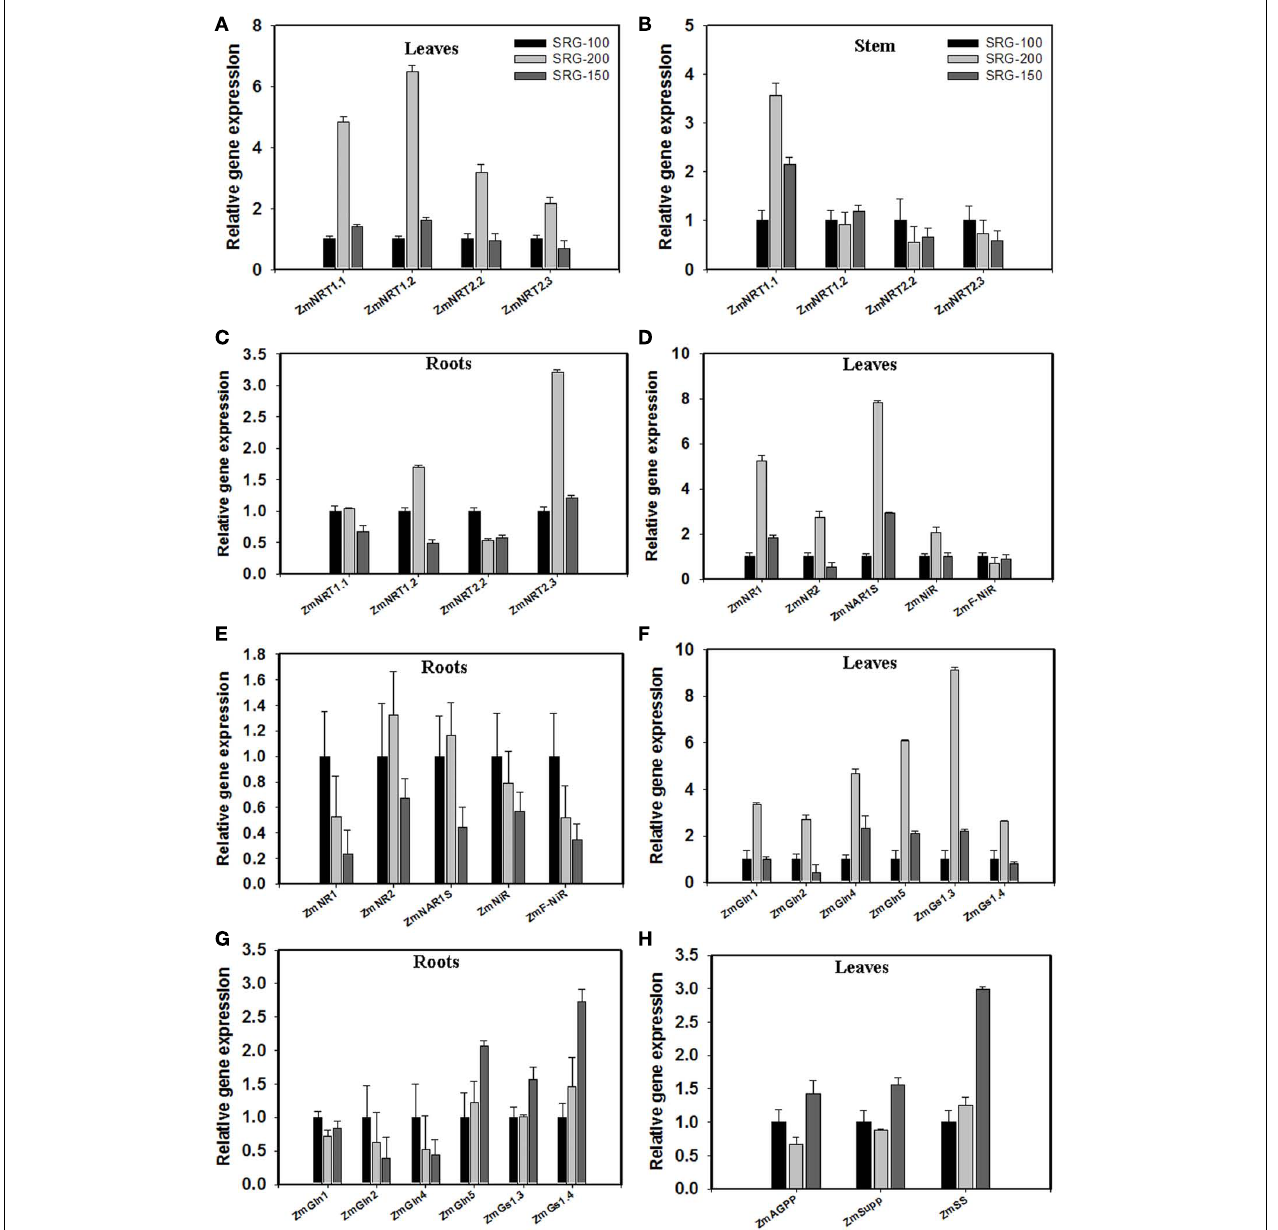
and nitrite reductase genes. (F,G) expression of glutamine synthetase genes in the leaves and roots of the three genotypes. ( H) expression of the starch and sugar synthetase genes in the leaves of the plants growing under N limitation. Data are means ± SD ( n = 3) and are representative of similar results from three independent